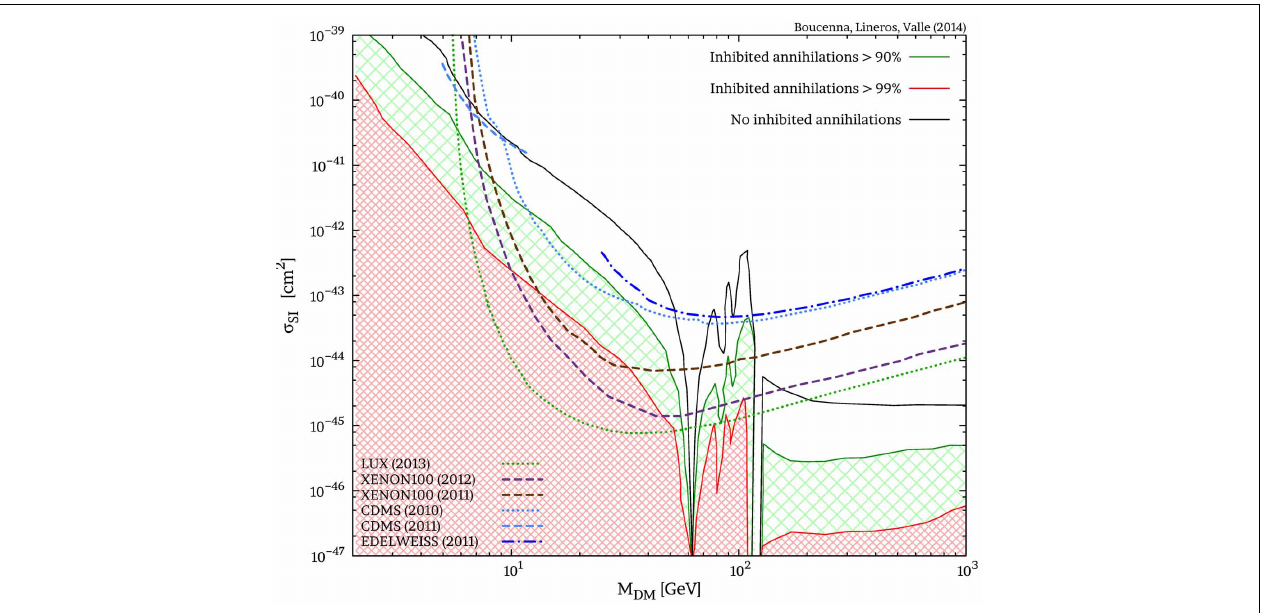
FIGURE 4 | Spin–independent cross section vs. dark matter mass. Exclusions from XENON100 [52, 53], CDMS [54, 55], EDELWEISS [56] and LUX [19] are shown. As in Figure 2 , we present cases where inhibited